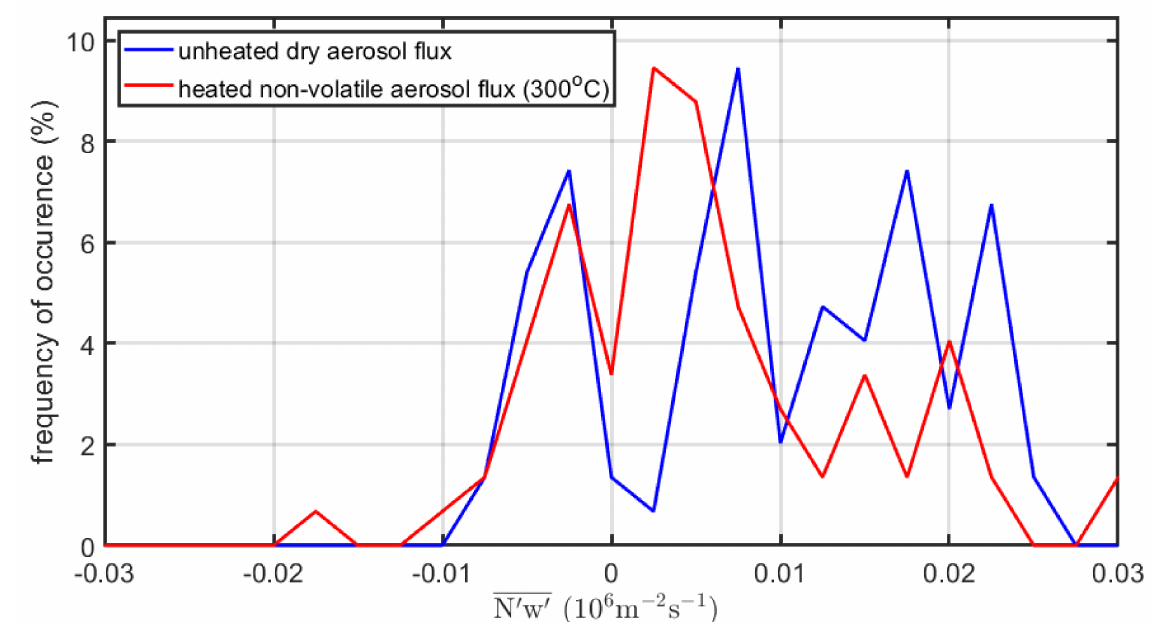
Figure 5. Frequency of occurrence of OPC (optical particle counter) aerosol number fluxes (corrected for limited time response but not for dry deposition). Blue curve is the unheated dry aerosol number flux, while red curve is the heated non-volatile aerosol flux (300 ◦